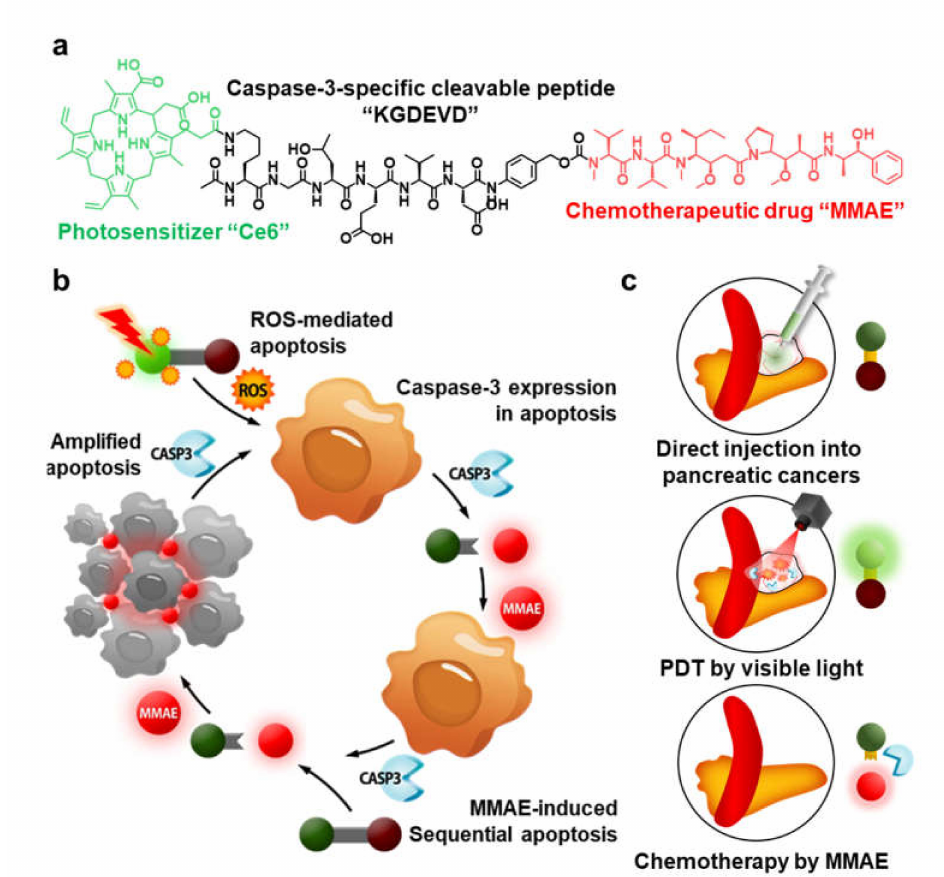
Figure 1. Light-activated monomethyl auristatin E (MMAE) prodrug nanoparticles and its ap- plication for pancreatic cancer treatment. ( a ) Photosensitizer (Ce6) and chemotherapeutic